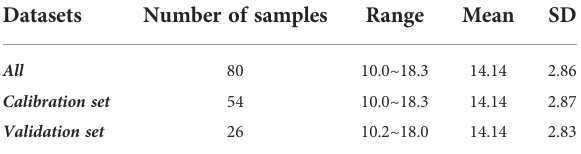
TABLE 4 Statistics of measured amylose content for the calibration and validation